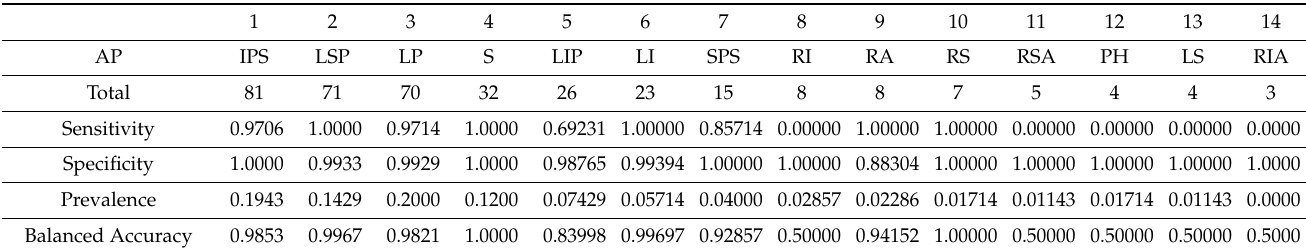
Table 4. Sensitivity analysis for the accurate prediction of the accessory pathway by the locAP AI algorithm for each of the 14 different pathways.